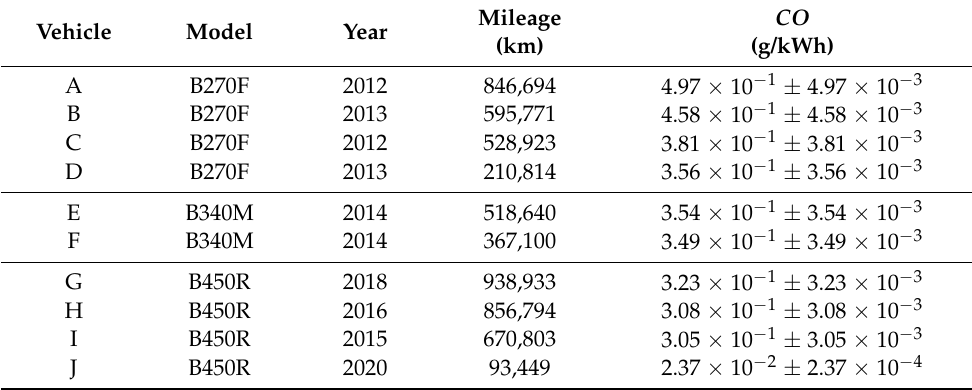
Table 7. Influence of mileage traveled on the evolution of ( CO ) emissions.